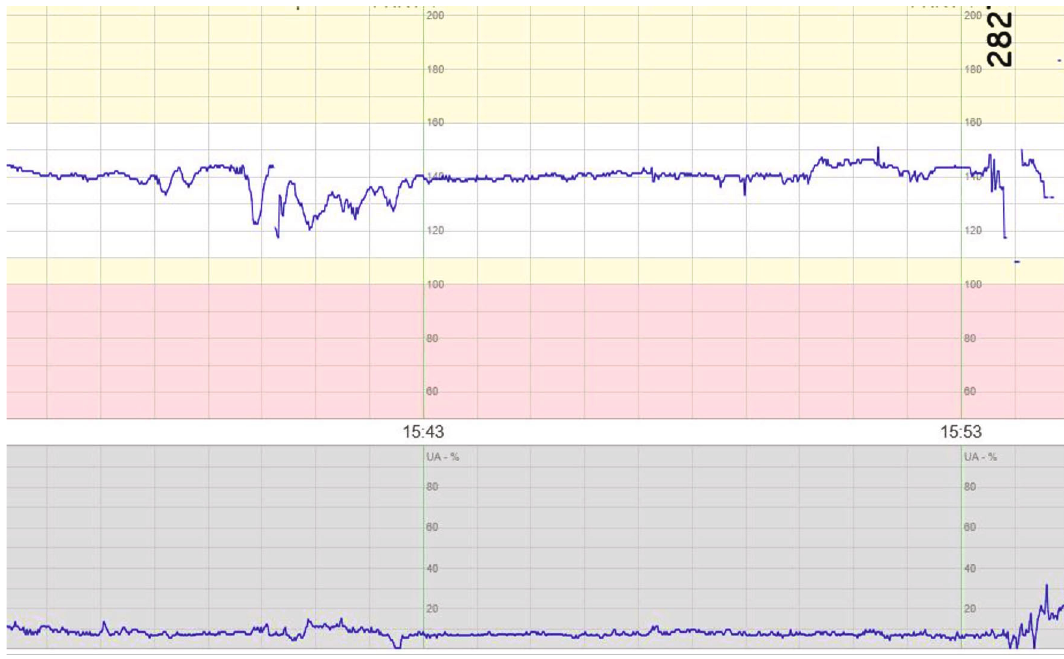
Figure 1: Patient 1 CTG at admittance to the